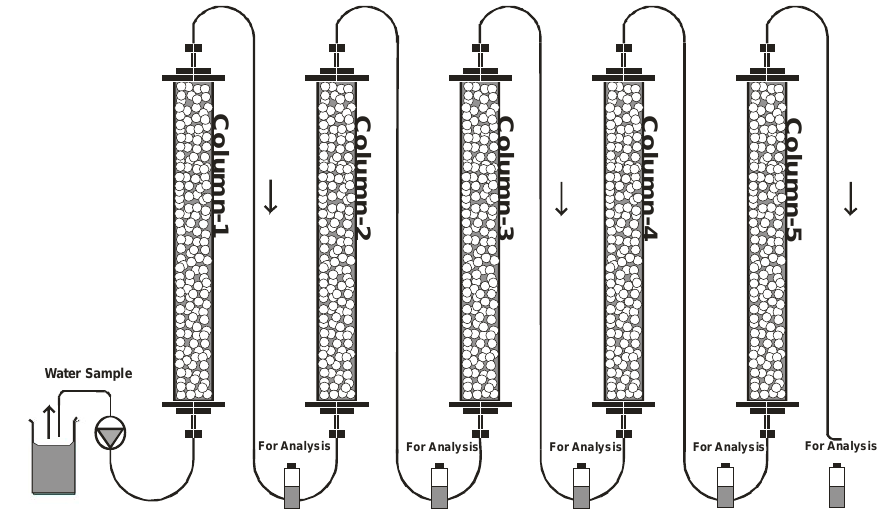
Figure 1. BDOC experimental set-up (adapted from Tihomirova, 2011).